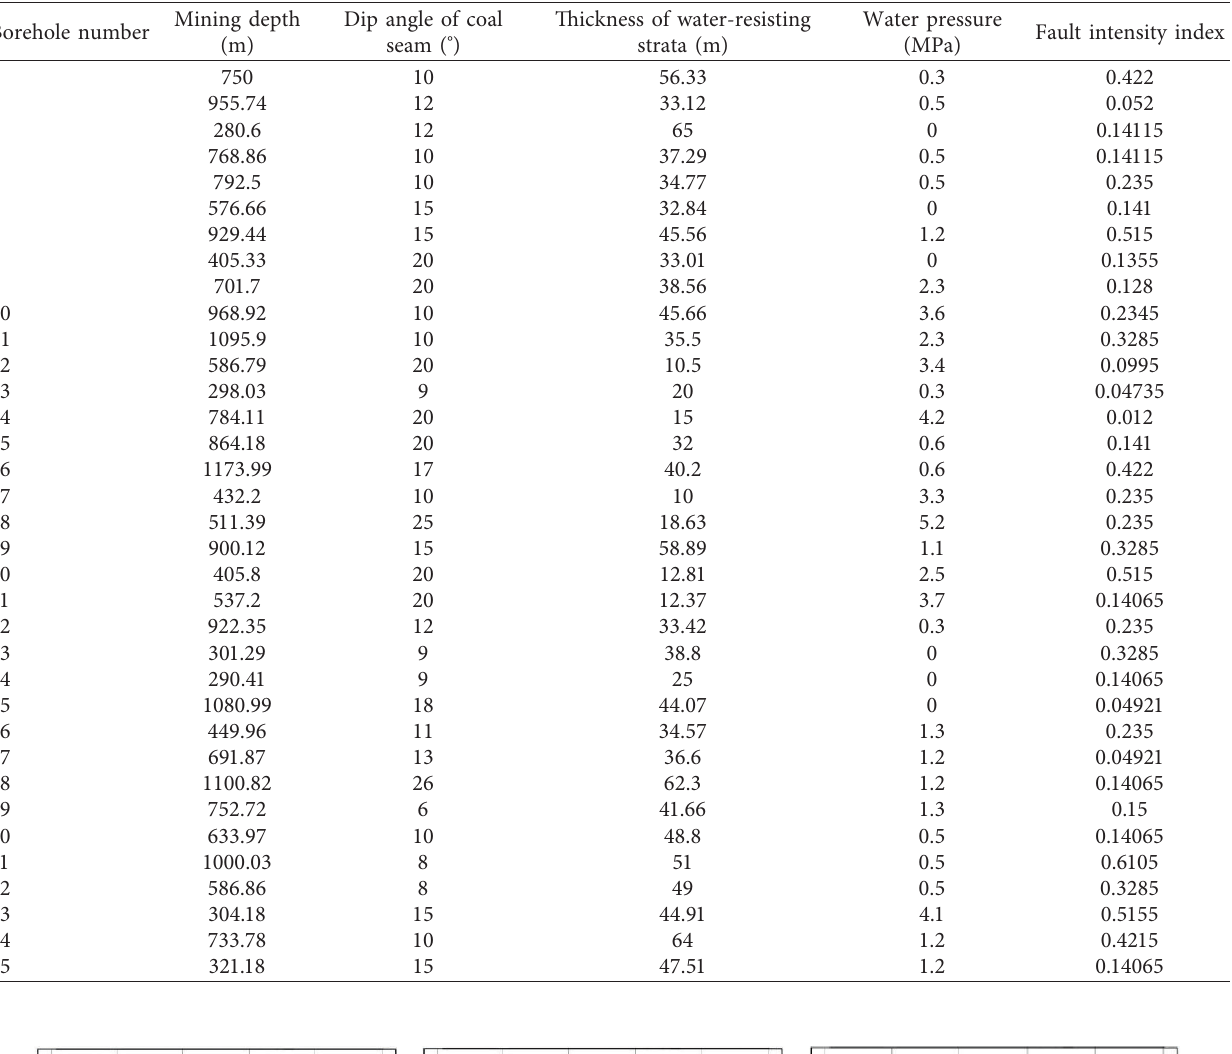
Table 1: Original data of